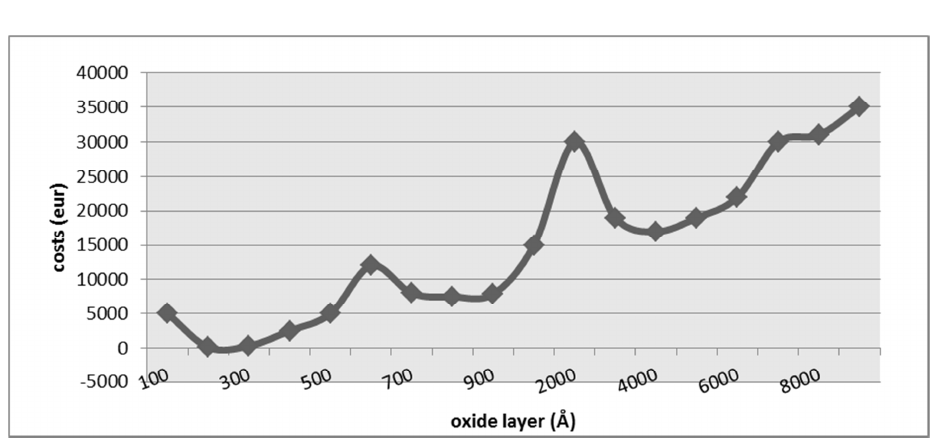
Figure 1 – Costs of continuous quality improvement (Source: own processing) Component of the graph from 800 Å to 1000 Å is estimated using Experiment